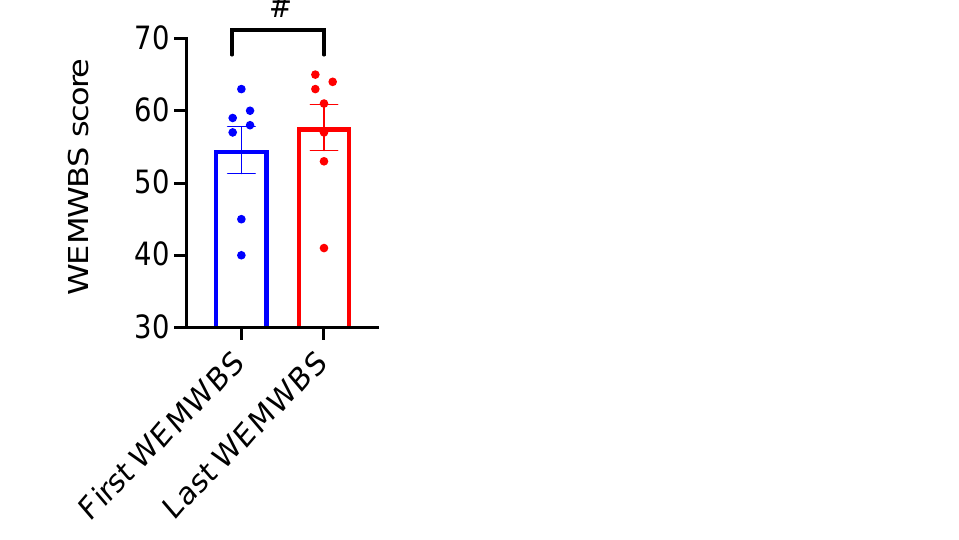
Figure 5. Mental wellbeing of the participants assessed via Warwick-Edinburgh Mental Wellbeing Scale (WEMWBS). WEMWBS scores of the participants at the last WEMWBS assessment show a trend towards increase compared to the first WEMWBS assessment (Paired t test, t = 2.27, df = 6, # indicate p = 0.0641, n = 7). Error bars indicate standard error means.